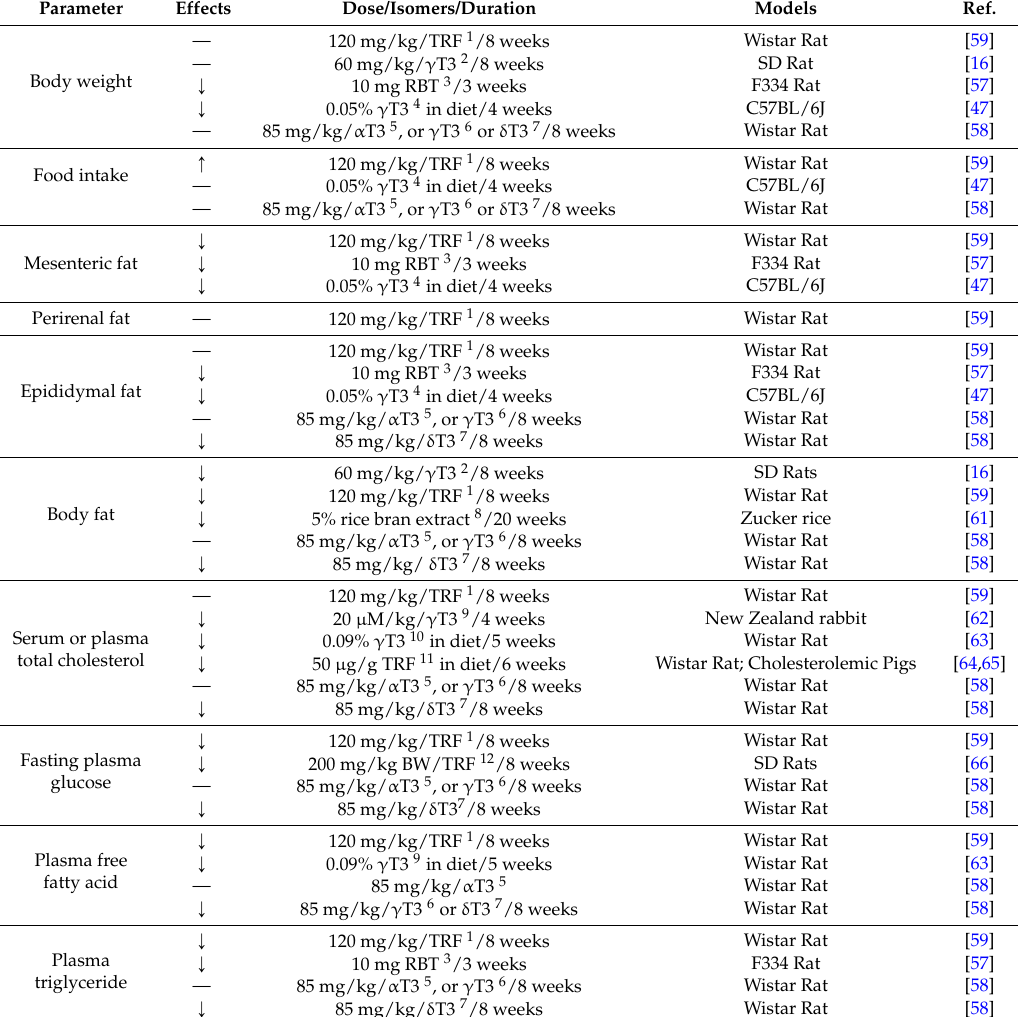
Table 1. Effects of tocotrienols (T3s) on body weight change, food intake, adipose tissue mass and serum lipid